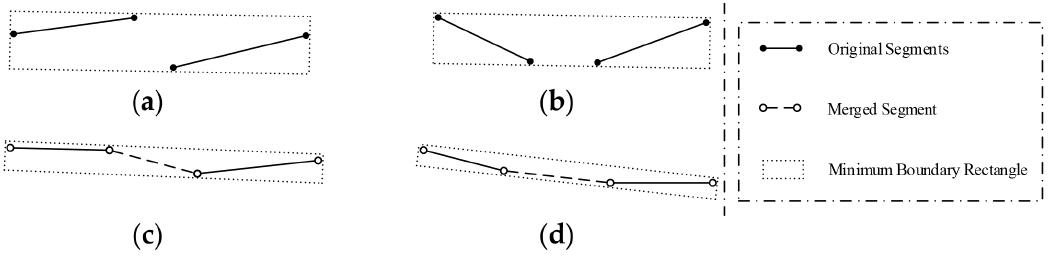
Figure 4. Calculating the geometric relationships between the segments at the same intersection. ( a ) The two roads are spatially parallel and neither intersect nor merge; ( b ) The two segments with two distinct orientations; ( c , d ) The two approximately collinear disjointed roads with larger Cost values should be combined into a single road.